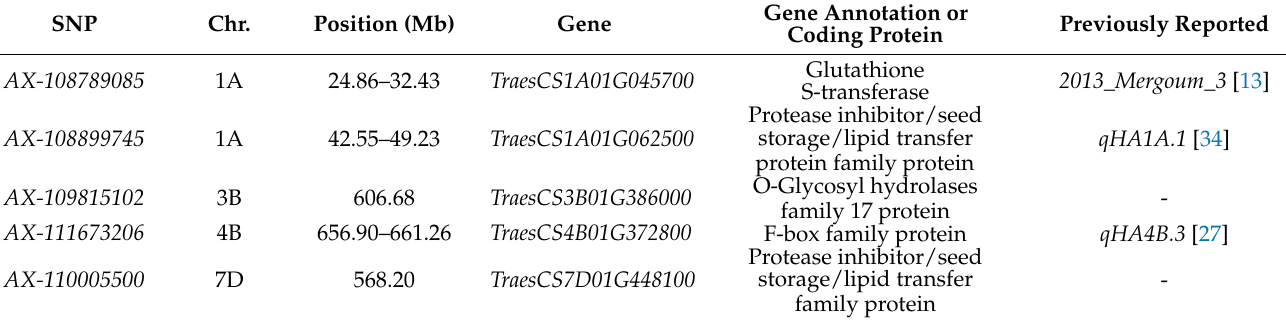
Table 4. Stable candidate gene function